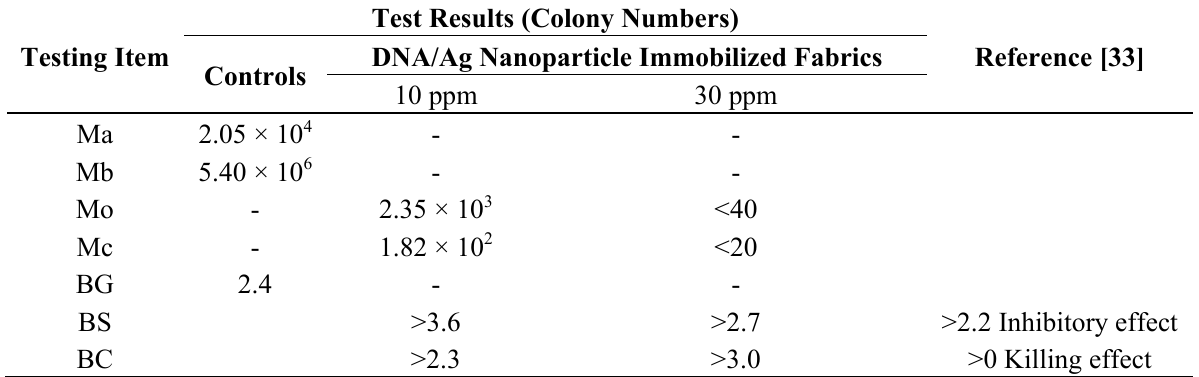
Table 1. Antibacterial evaluation